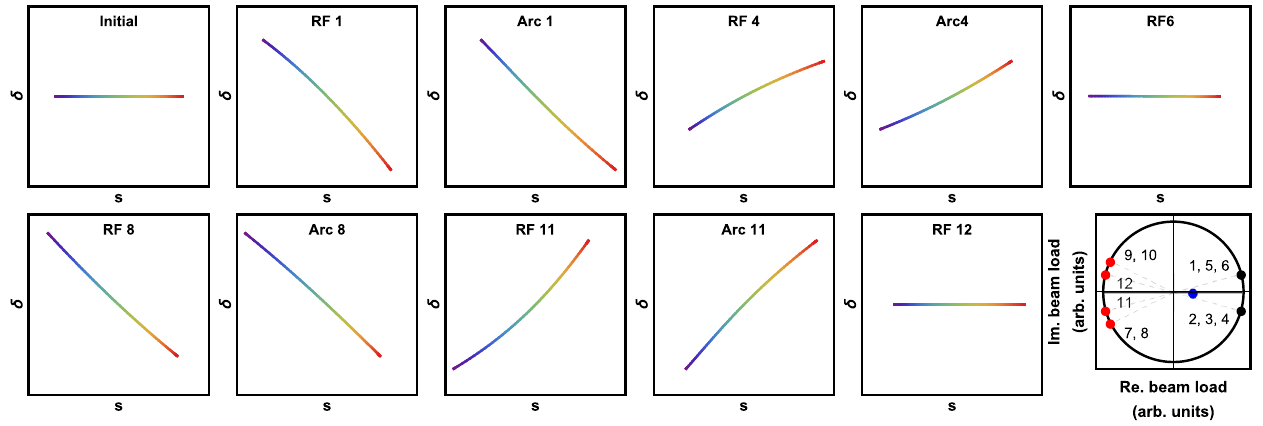
FIG. 10. Energy spread minimizing match with SR loss compensation using separate transport. Shown longitudinal phase spaces correspond to the example beam at the exit of the element specified. Applicable to, e.g., LHeC. rf beam load plot shows phase choices during acceleration (black), deceleration (red), and resultant